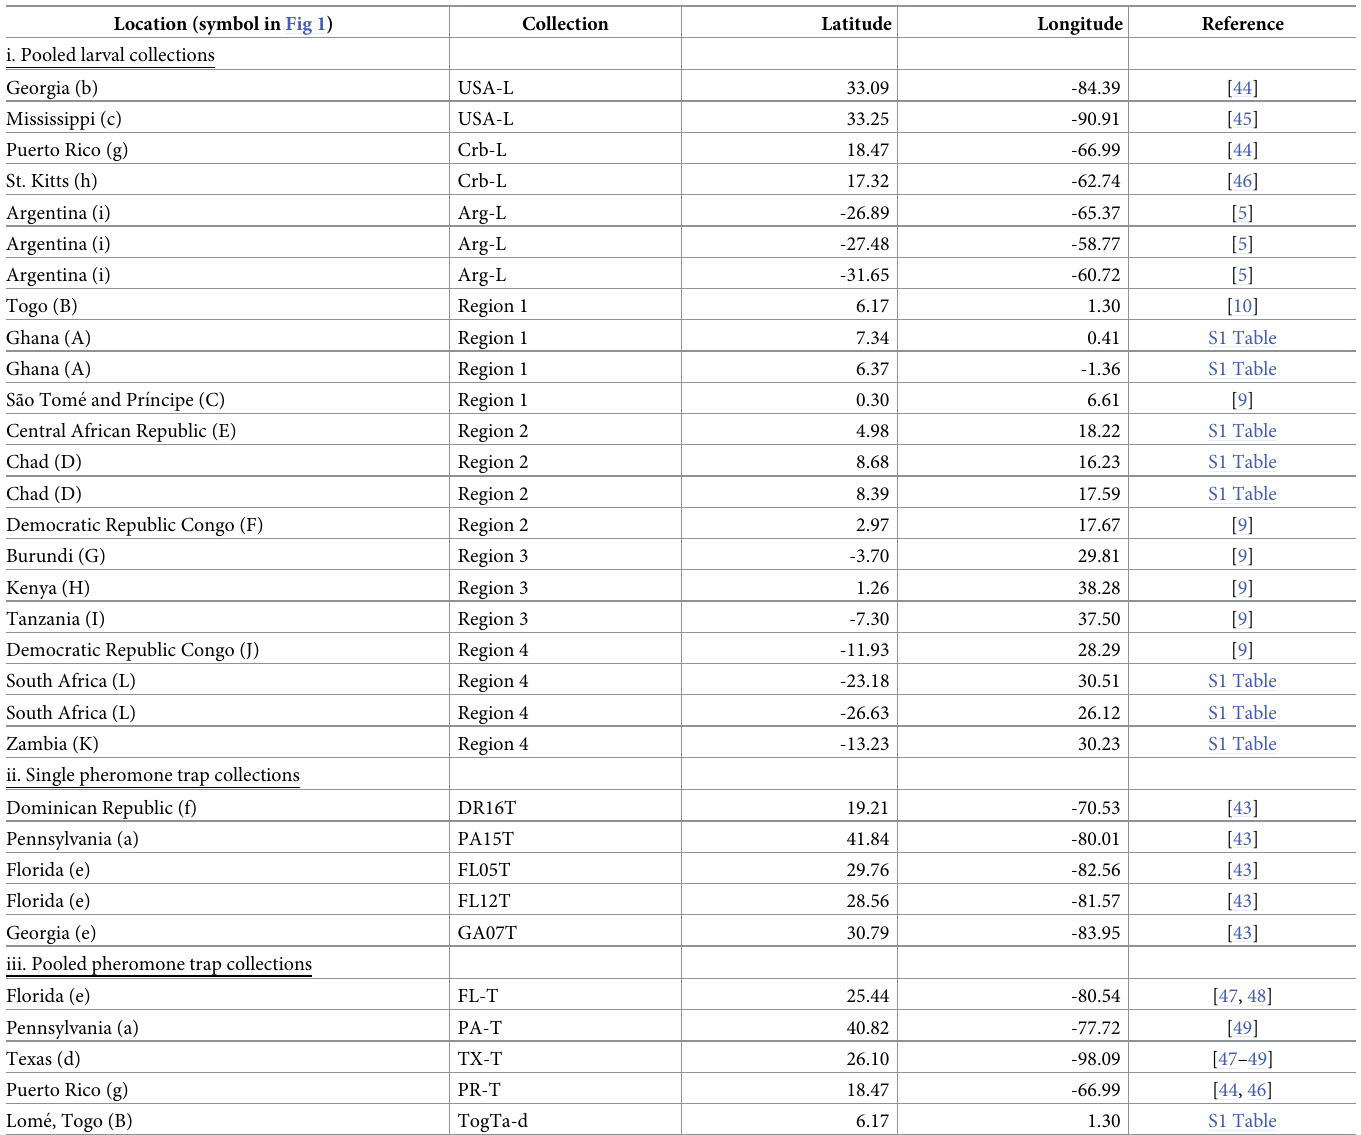
Table 1. Fall armyworm